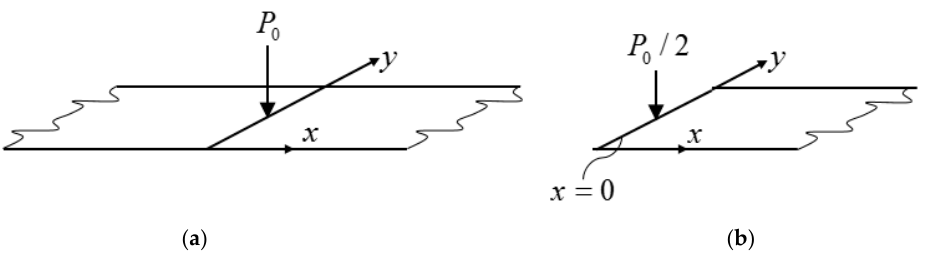
Figure 10. Long plate subjected to a concentrated load ( a ) and the corresponding half plate ( b ).